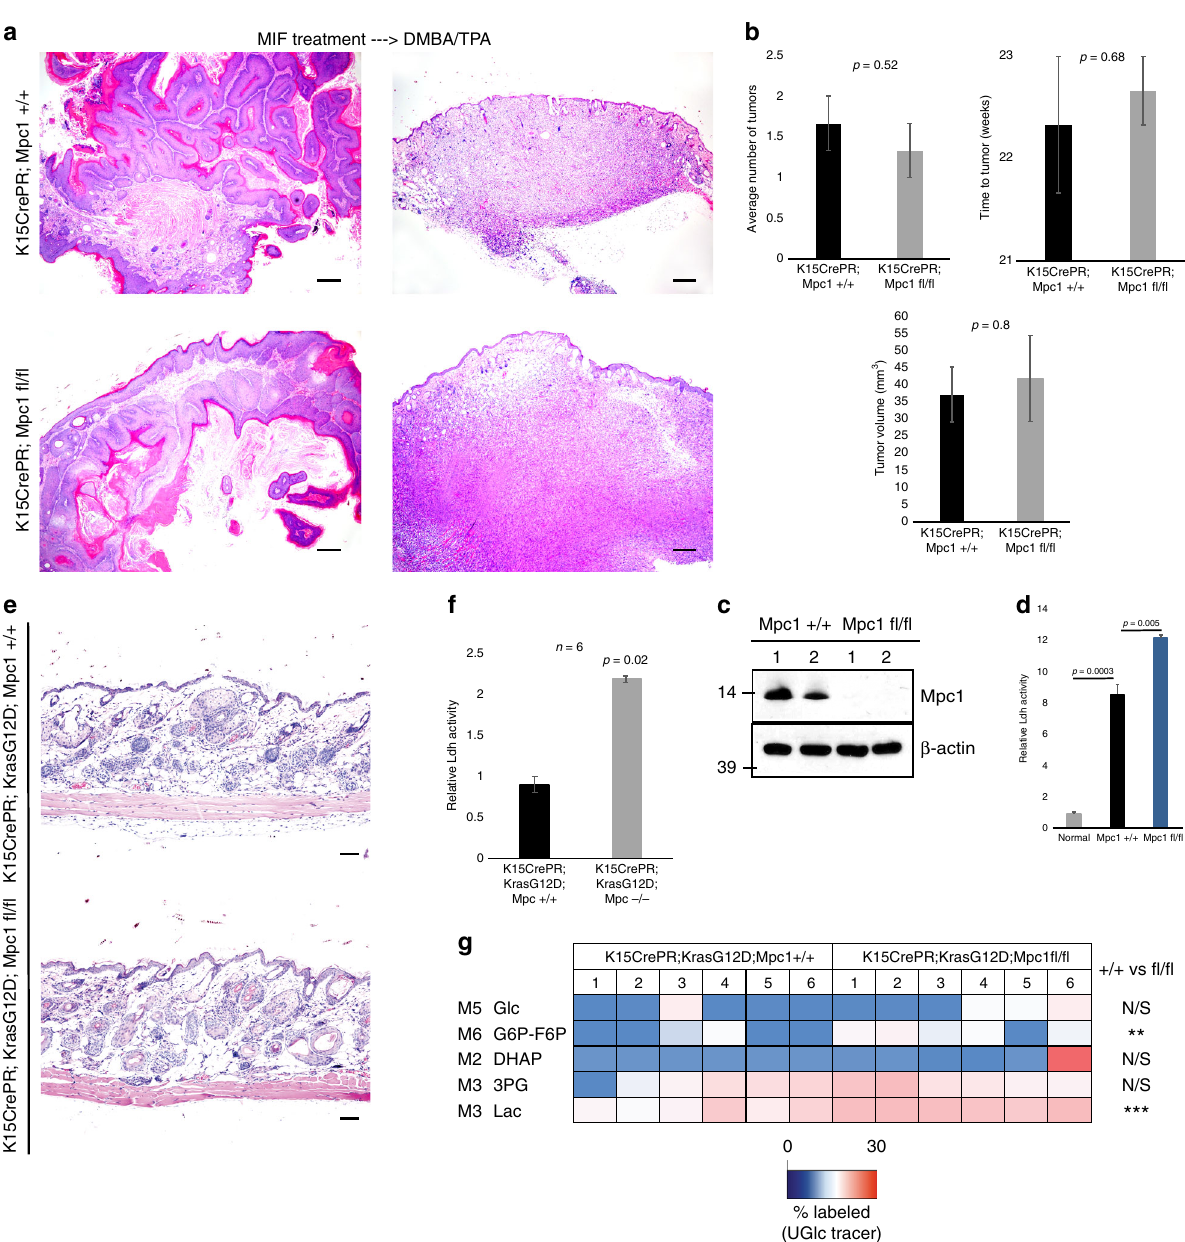
Fig. 6 Induction of Ldh activity by deletion of mitochondrial pyruvate transport does not affect tumor initiation or progression in SCC. a Coupling DMBA/ TPA carcinogenesis to transgenic deletion of mitochondrial pyruvate carrier function allowed for an examination of tumorigenesis following stimulation of Ldh activity. Haematoxylin and eosin stain shows similar histology in wild-type and Mpc1 -null tumors. Scale bars, 200 µ m. b Quanti fi cation of time to tumor formation, number of tumors, and tumor volume formed showed that Mpc1 deletion did not affect tumorigenesis. Each bar represents n = 12 mice per genotype. Shown as mean ± SEM. Paired t test was performed, P < 0.05 shown for knockout vs. wild-type tumors. c Western blotting indicated that the genetic deletion of Mpc1 was effective. d Ldh activity on lysate from normal skin and wild-type vs. Mpc1 -null tumors. Each bar represents the relative Ldh activity signal for each genotype type where n = 12 mice per genotype. Shown as mean ± SEM. Paired t test was performed, P < 0.05 shown for each tumor genotype vs. control skin. e Mice with just gain of Kras G12D were crossed with fl oxed- Mpc1 mice to generate one-hit mice with and without Mpc1 expression. Haematoxylin and eosin stain shows similar hyperplasia in wild-type and Mpc1 -null tumors. Scale bars, 100 µ m. f Ldha activity in lysate generated from wild-type vs. Mpc1 -null tumors. Each bar represents the relative Ldh activity signal for each genotype type, where n = 3 mice per genotype. Shown as mean ± SEM. Paired t test was performed, P < 0.05 shown for wild-type vs. knockout hyperplastic skin. g [U- 13 C 6 ]glucose tracing for glycolytic intermediates shows that while glucose uptake did not change, the production of lactate was increased by loss of Mpc1 in HFSCs. Labeled metabolites were extracted and analyzed by LC – MS from hyperplastic tissue from each genotype. Heatmap depicts percent labeled glycolytic intermediate isotopomers from tissue isolated from six mice per genotype. Student ’ s paired t test was performed, ∗ P < 0.05; ∗∗ P < 0.01; ∗∗∗ P < 0.001; NS, P > 0.05; n =